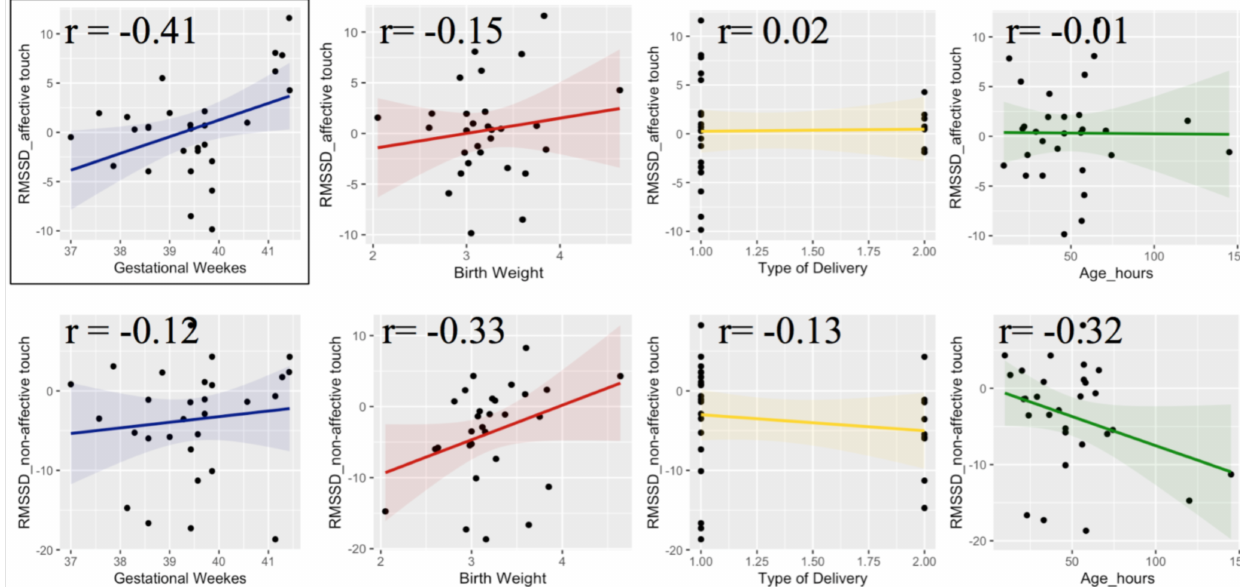
Figure 6. Correlation between RMSSD variation during tactile stimulations and neonatal information, including gestational weeks (blue), birth weight (red), type of delivery (yellow) and postnatal age in hours